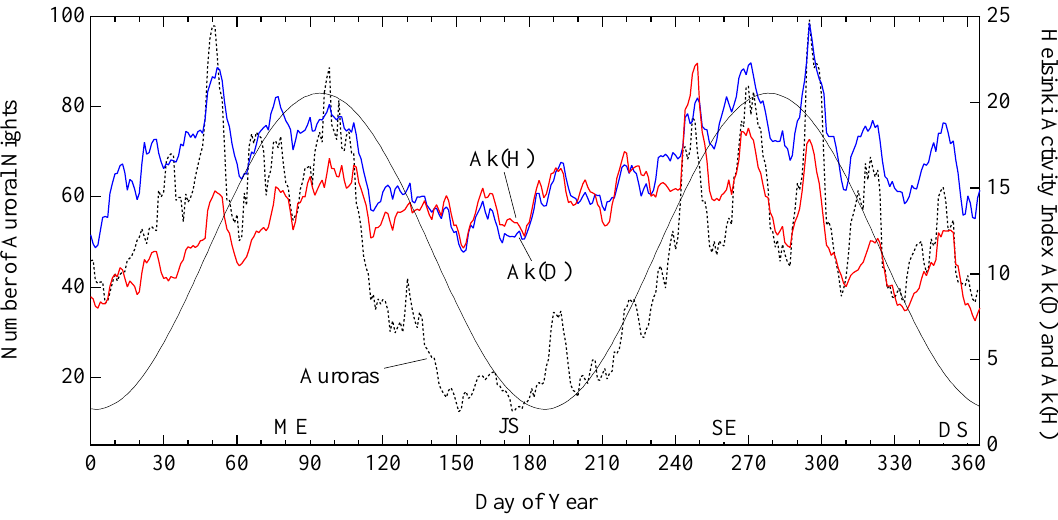
Fig. 8. Superposed epoch analysis of daily values of Helsinki Ak(D) , Ak(H) , 1844–1880, and of the occurrence of mid-latitude auroras. The auroral data are from Fritz’s (1873) catalogue 1844–1872. The daily values are 7-d running means. The smooth curve shows the semiannual activity calculated from the Russell-McPherron model. ME = March equinox; JS = June solstice, SE = September equinox, DS = December